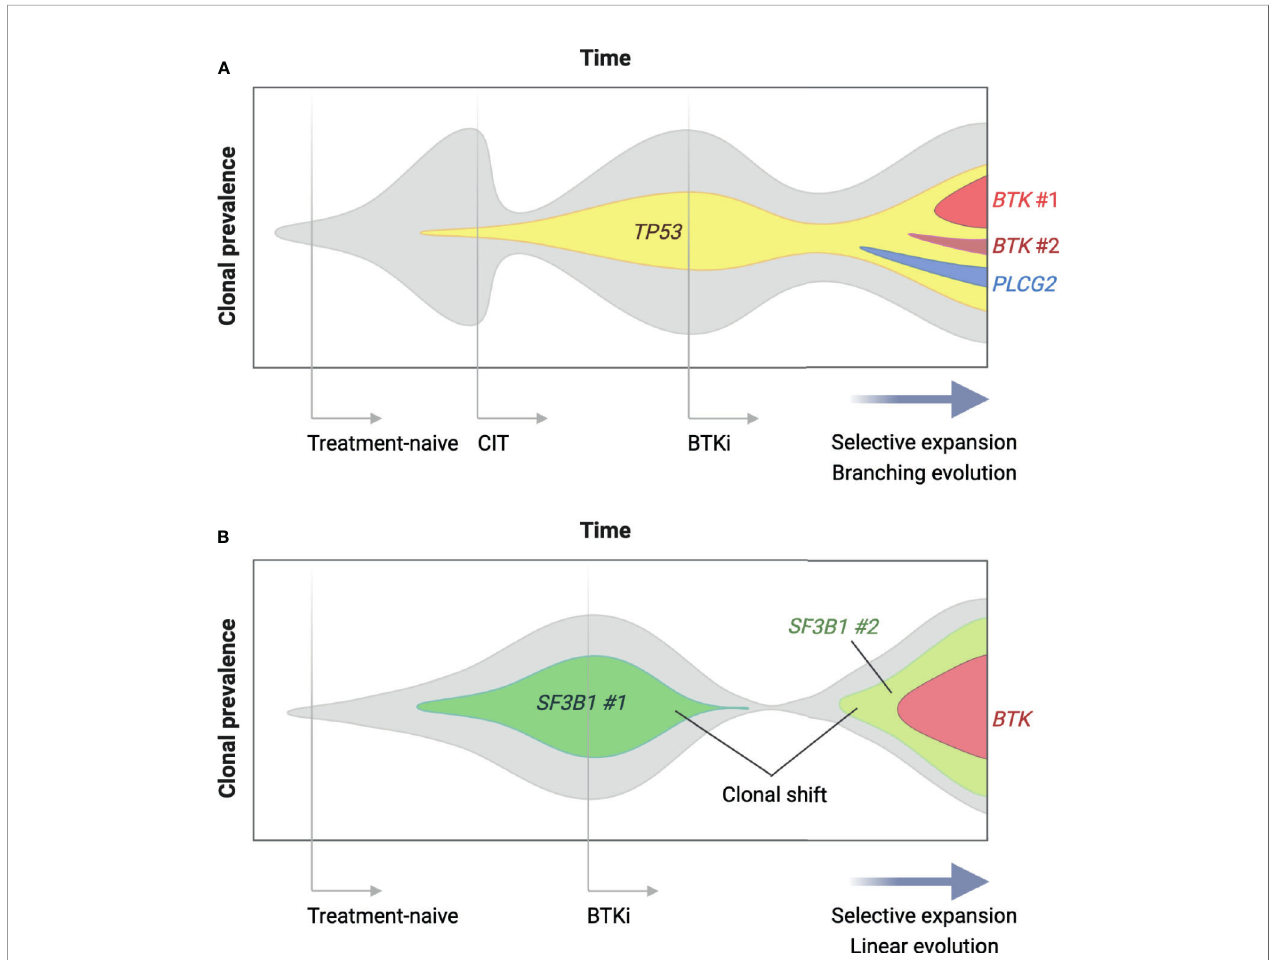
FIGURE 3 | Clonal evolution of BTKi-resistant CLL. Clonal architecture of CLL changes over time under the selective pressure of treatment and in the presence of driver gene mutations. Panel (A) is a schematic representation of a patient who was treated with chemoimmunotherapy (CIT) as fi rst-line and a BTK inhibitor (BTKi) as second-line therapy for CLL. Two lines of therapy selectively expanded a parental clone with a driver gene mutation ( TP53 in this case), which became a parental clone of BTKi-resistant disease. Multiple BTK and PLCG2 mutations arose after branching evolution and were detectable at relatively low allele frequency at the time of progression. Panel (B) shows a patient who underwent a major shift in clonal dominance from one clone ( SF3B1 mutation #1) to another ( SF3B1 mutation #2) during treatment with a BTKi. Linear evolution of the emerging clone led to a single dominant BTK mutation at progression detectable at high allele